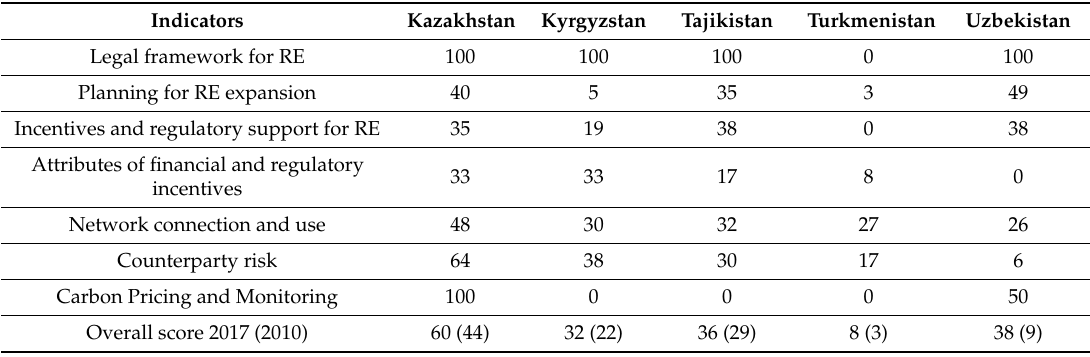
Table 10. Renewables (RE) Policy Scores, 2017 (Source: author, based on Renewable Indicators for Sustainable Energy, World Bank, http: // rise.worldbank.org / ). Indicators Kazakhstan Kyrgyzstan Tajikistan Legal framework for RE 100 Planning for RE expansion 40 Incentives and regulatory support for RE 35 Attributes of financial and regulatory incentives Network connection and use Counterparty risk Carbon Pricing and Monitoring 100 Overall score 2017 (2010) Note: 100—maximum